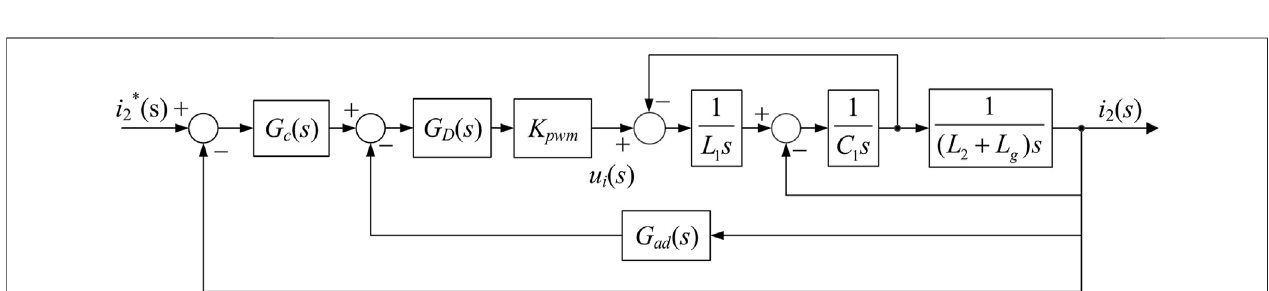
FIGURE 2 | Closed loop control block diagram of the grid-connected inverter in the αβ coordinate system.